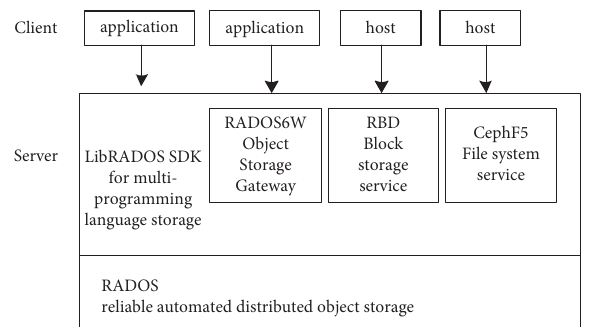
Figure 3: Ceph storage solution.